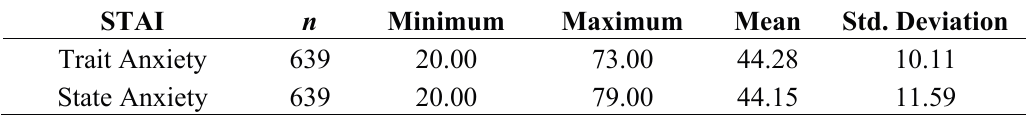
Table 2. Descriptive statistics for State-Trait anxiety inventory (STAI) scale. STAI n Minimum Maximum Mean Std. Deviation